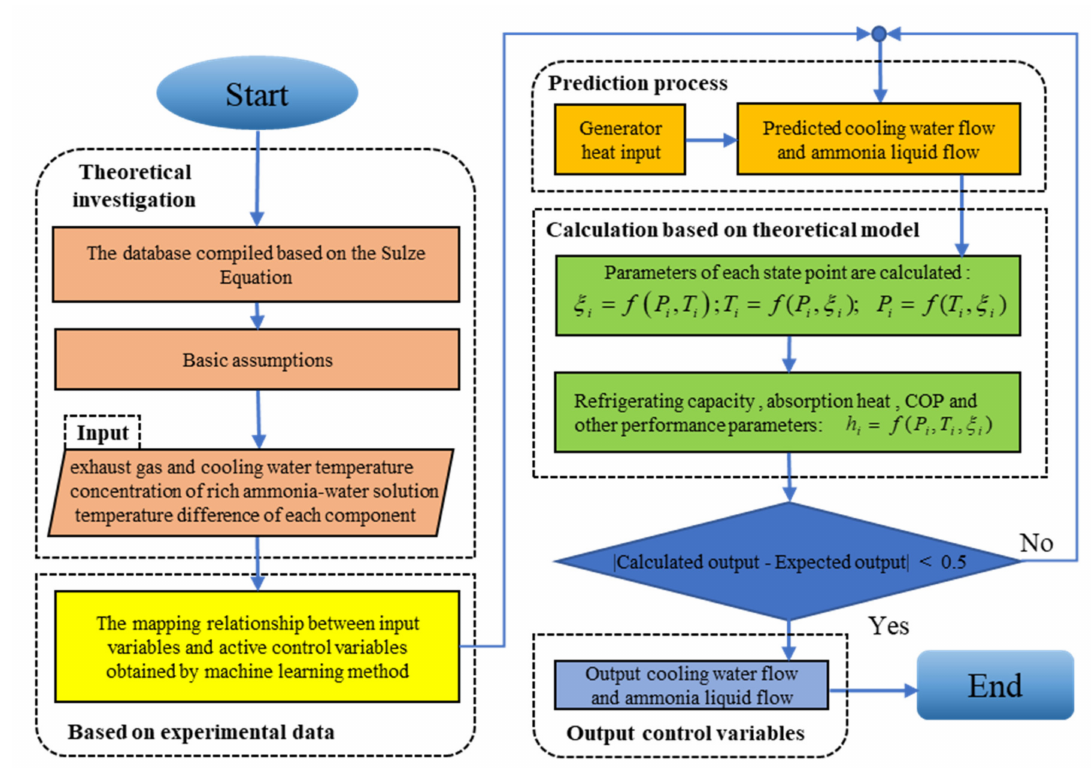
Figure 3. Schematic of the solution strategy for prediction and